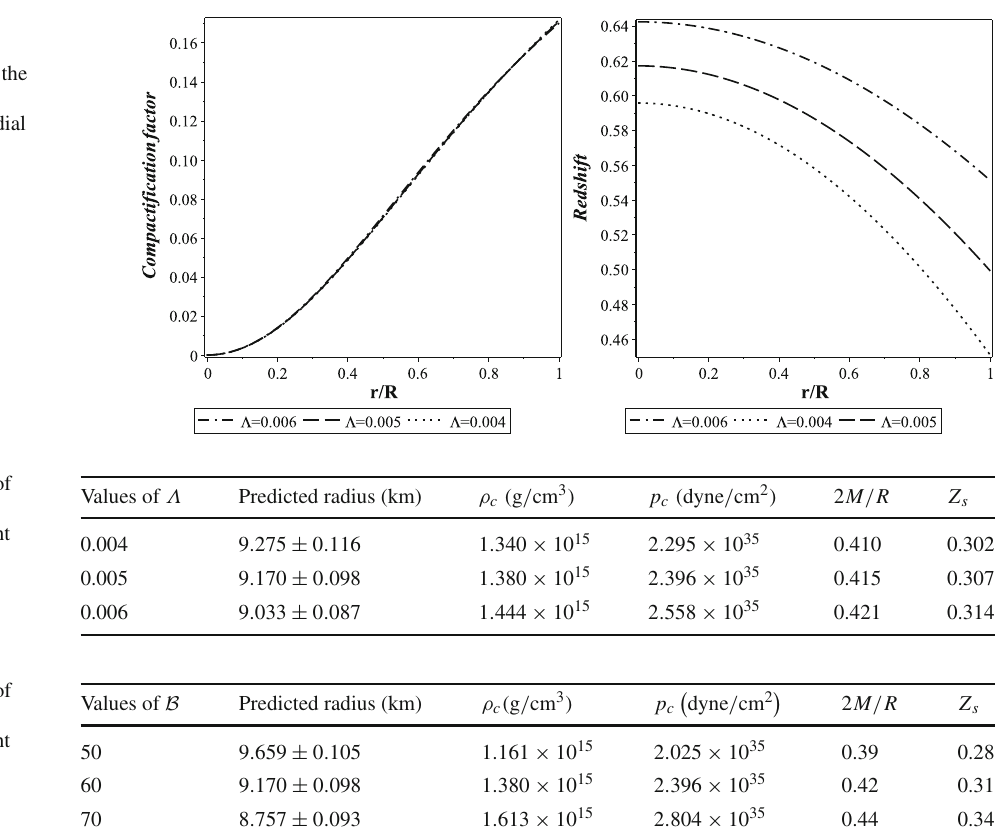
Table 3 Numerical values of physical parameters for LMC X − 4 for the different values of B and Λ = 0 .